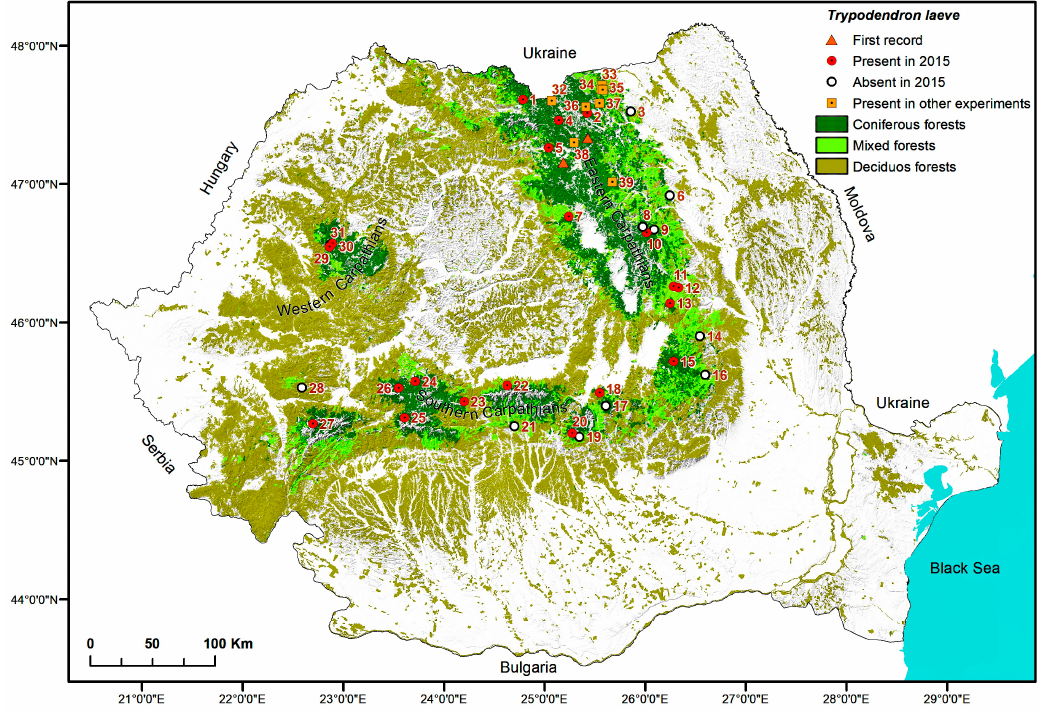
Figure 1. Sampling locations surveyed for the occurrence of Trypodendron laeve in 2015 and locations where it was found on other occasions mentioned in this study.